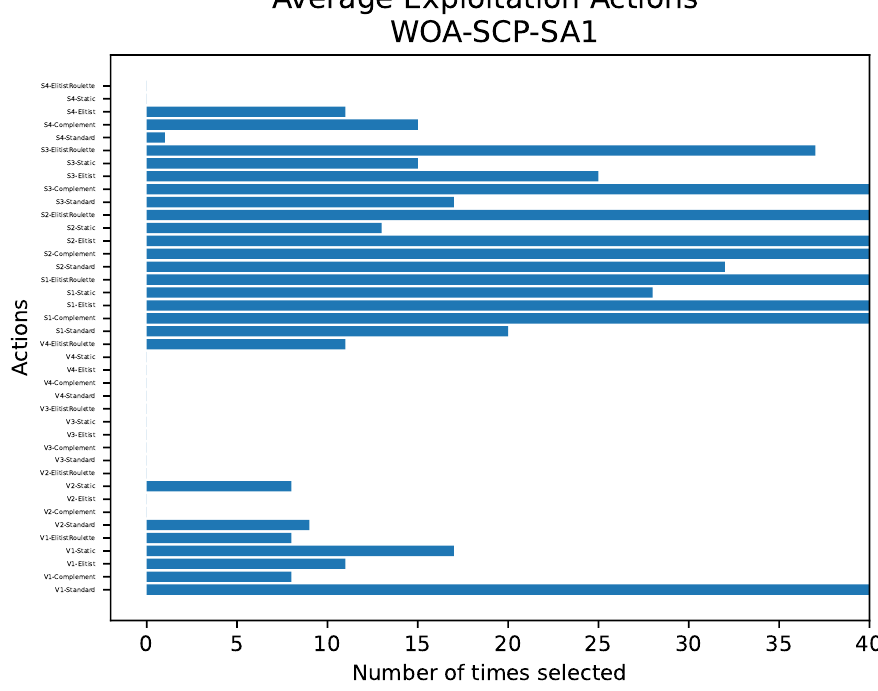
Figure 6. WOA-SA1—The average number of actions in the exploitation state.